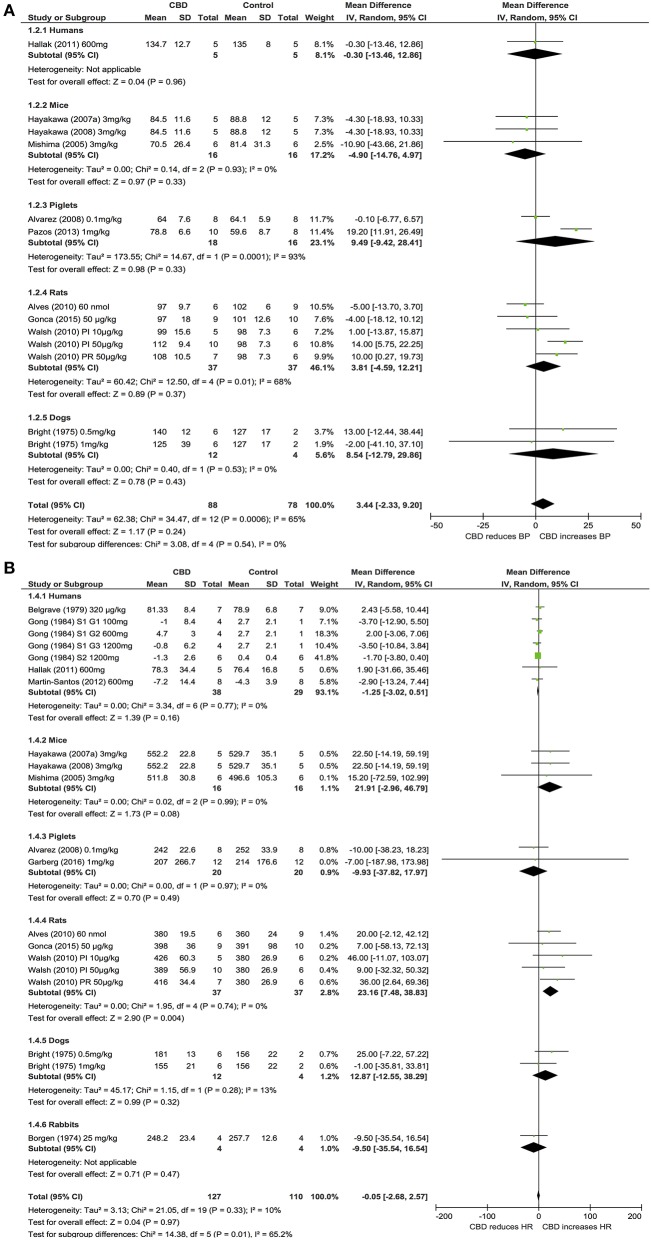
Changes in BP (A) and HR (B) induced by acute CBD dosing.